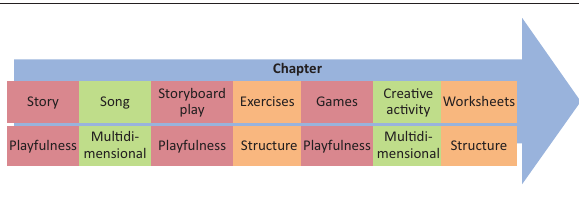
FIGURE 1: Typical structure of a